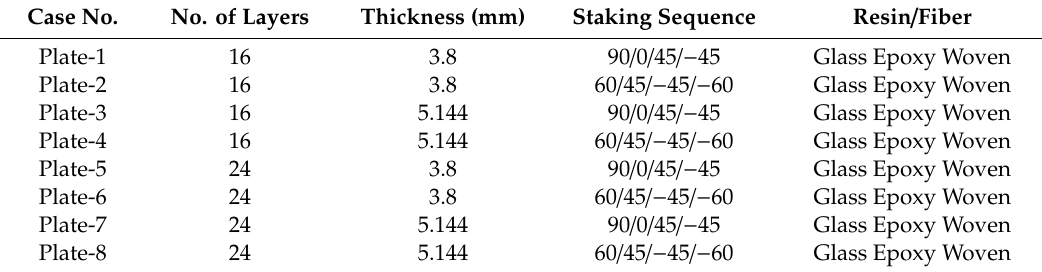
Table 11. Proposed new plate designs.